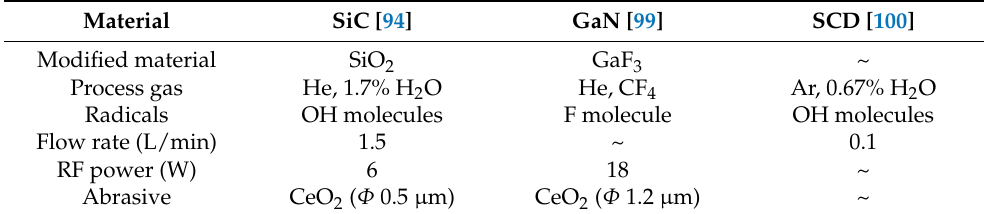
Table 2. The processing parameter for different materials using PAP.